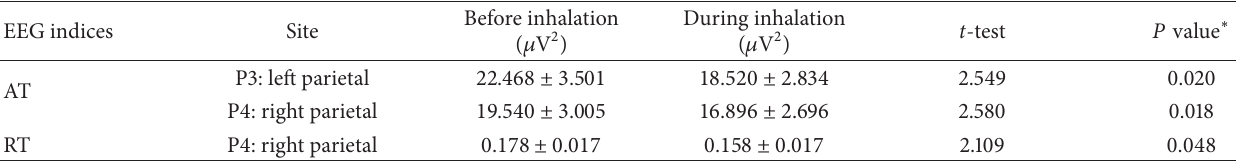
Table 5: Effect of uninasal (right nostril) inhalation of essential oil of A. koreana twigs on EEG activity in both